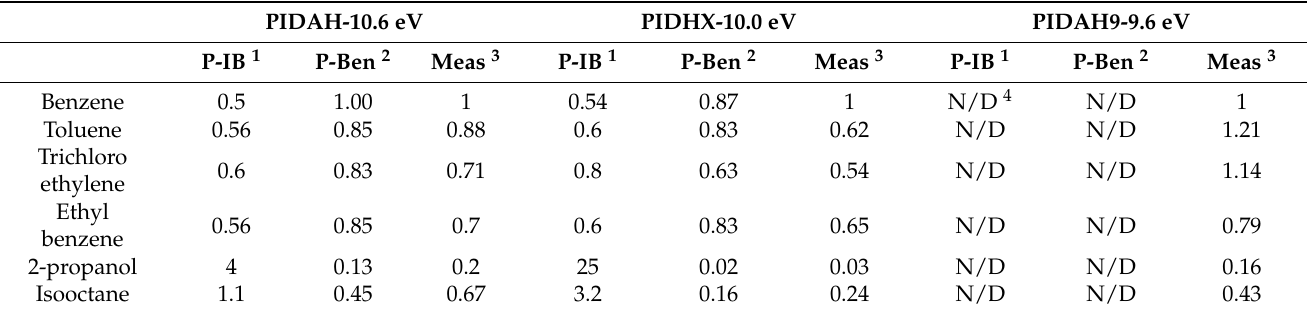
Table 6. Comparison of benzene’s recalculated and measured response factors.